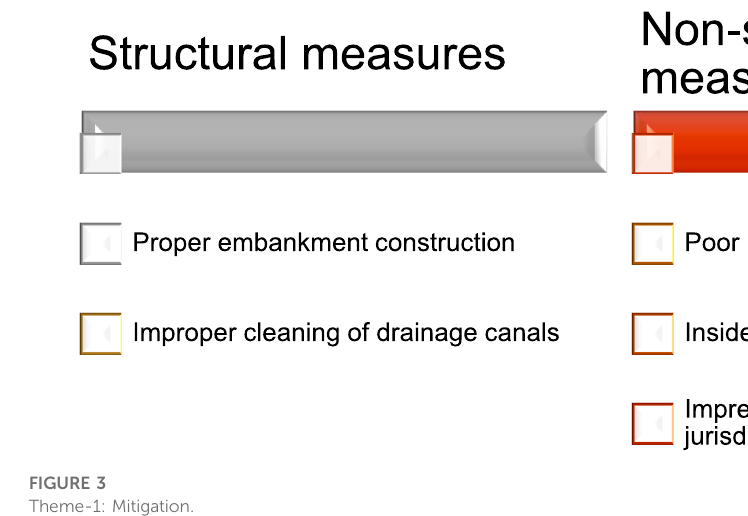
FIGURE 3 Theme-1: